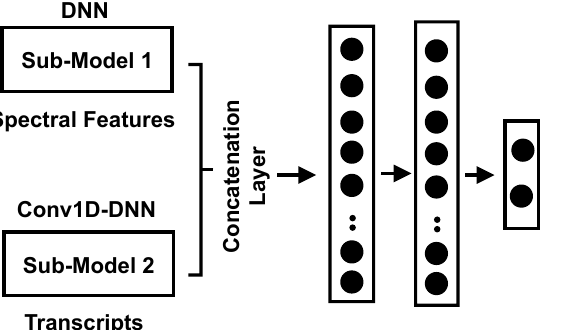
Figure 9. The structure of combining the two approaches of the signal-based submodel and the transcript-based